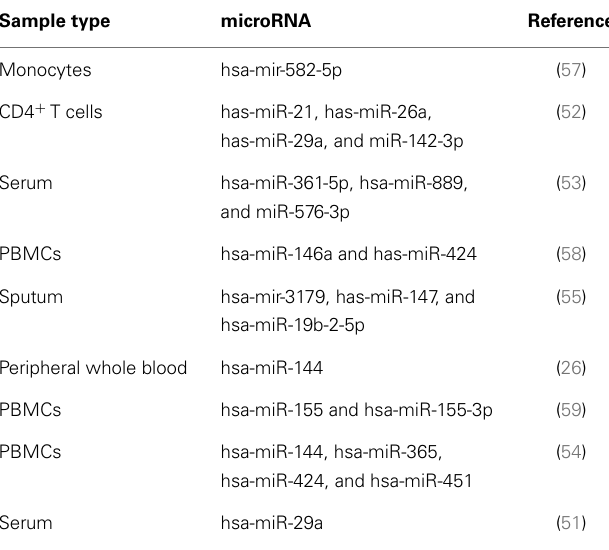
Table 2 | Candidate microRNA biomarkers for activeTB